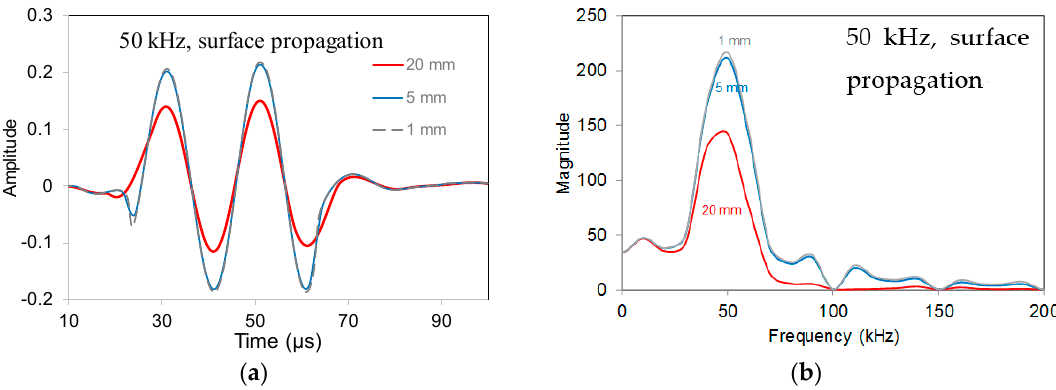
Figure 4. ( a ) Waveforms received by different size sensors for the case of surface source and excitation frequency of 50 kHz; ( b ) FFT functions of waveforms received by different size sensors (exc. frequency at 50 kHz and surface source). The corresponding waveforms are depicted in Figure 4a.